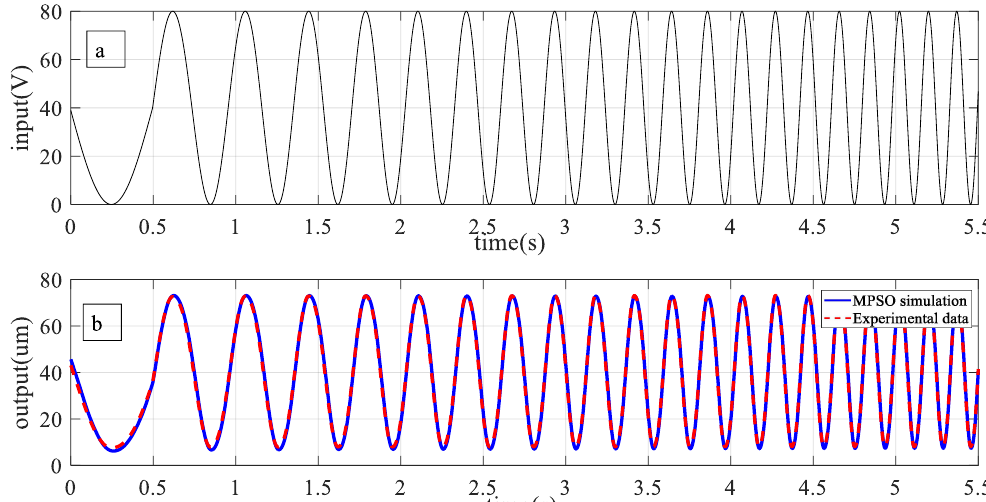
Figure 13. Performance validation of the overall model, measured and predicted output ( a ) input signal with varying frequency ( b ) output response.